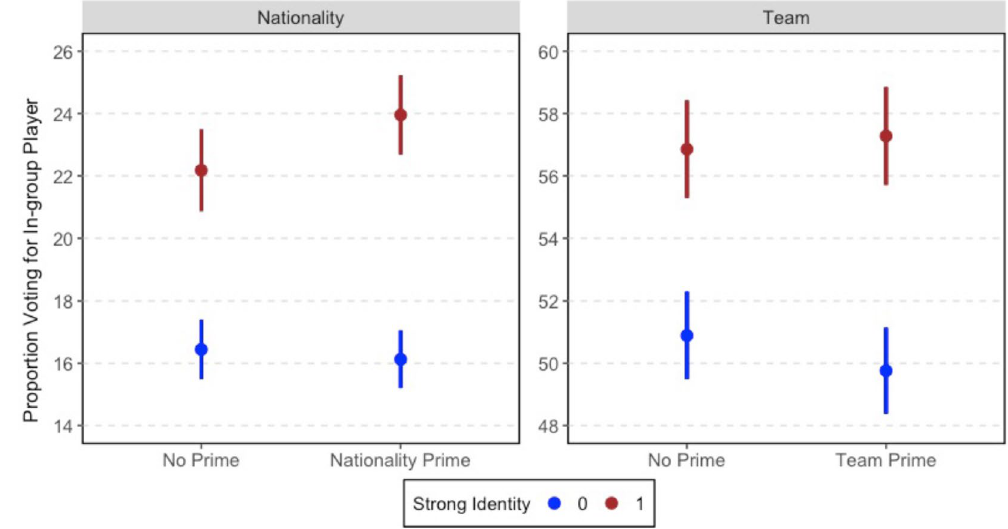
Figure 6. Effect of in-group primes conditional on social identity strength.